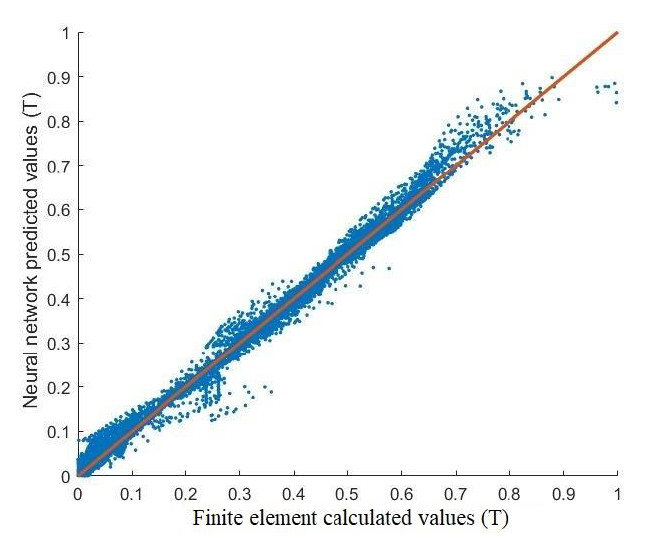
Figure 11. Comparison of magnetic flux density values of ui-shaped inductor.